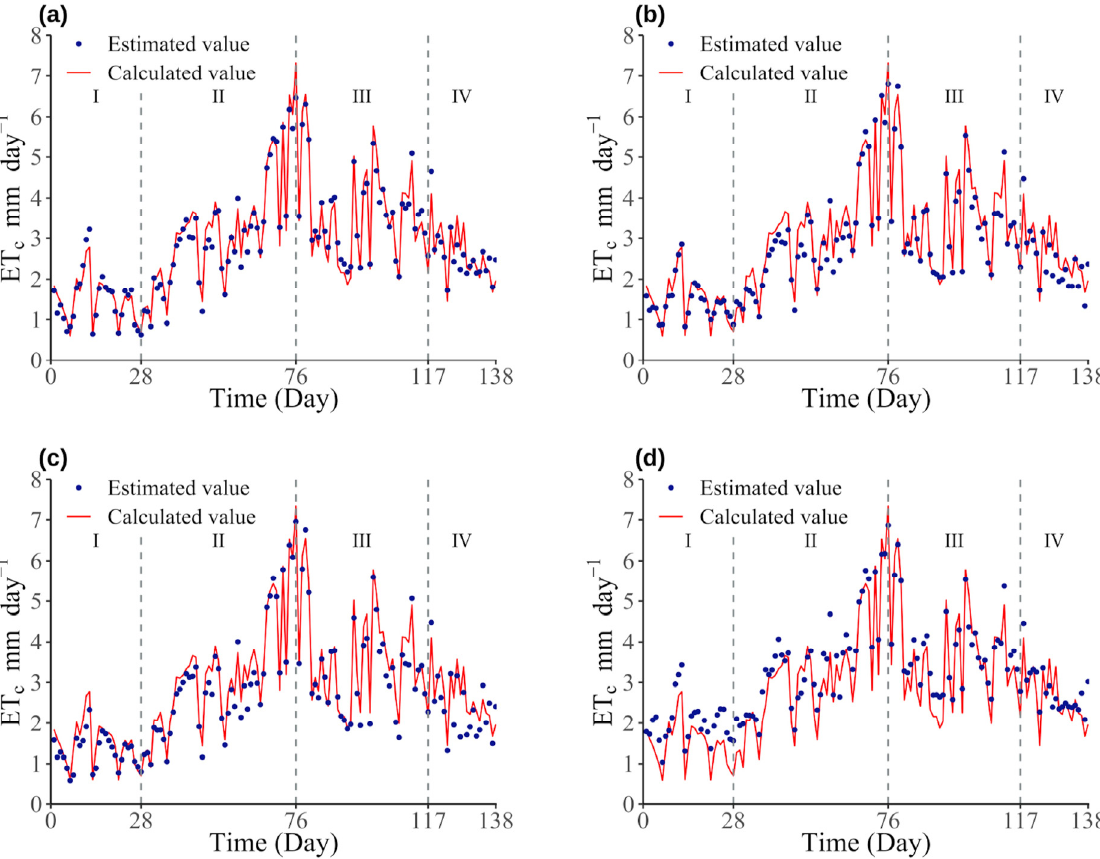
Figure 7. Comparison of simulated and calculated values of spring maize ET c in 2019 of different models with K c, T ave , T max , n and RH as the input: RF–SVR–PSO model ( a ), SVR model ( b ), BPNN model ( c ) and RF model ( d ). The areas labeled I, II, III and IV indicate the initial stage, crop development stage, mid-season stage and late-season stage, respectively.